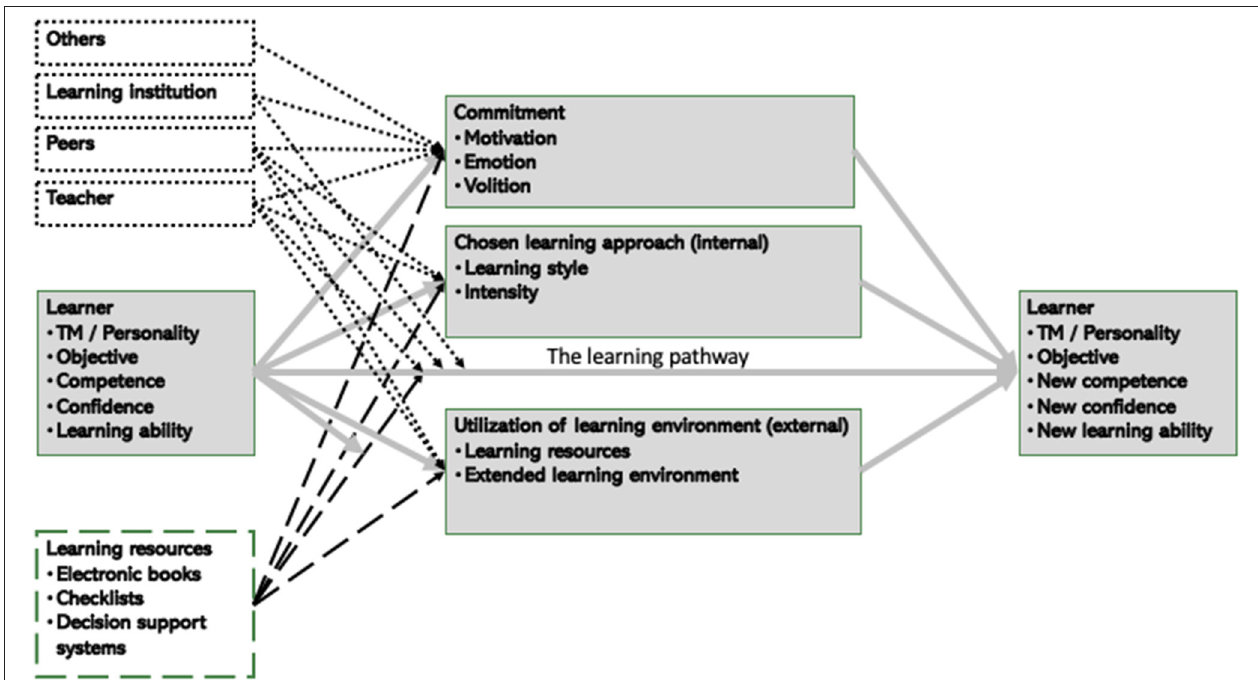
FIGURE 7 | Learning from the perspective of the